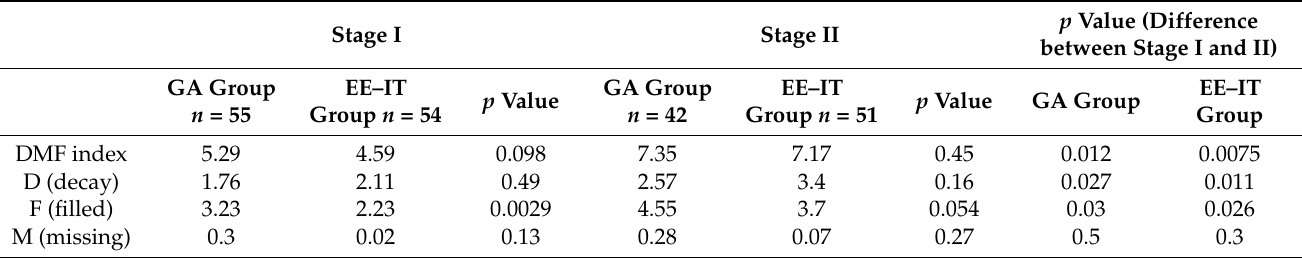
Table 1. Mean values of the DMF index and its components among the students of the gastronomic group (GA group) and electro-engineering and information technology school group (EE–IT group) in the first and second stages of the study.